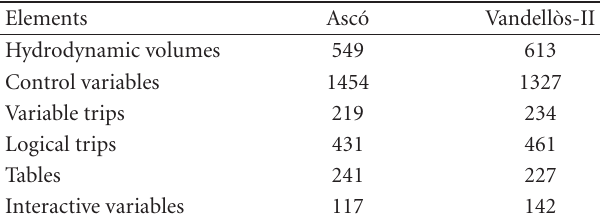
Table 1: Elements in Asc´o and Vandell`os-II